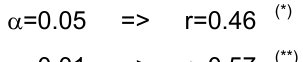
Table 5: Linear correlation between pairs of variables: TNF- α , IL-2, IFN- γ , IL-10, IL-4, CD 4+ T and CD 8+ T lymphocytes, plasma viral load (VL), and CD count for six G1, three G2, and eight G3 individuals, all with HIV-1, sick or not.